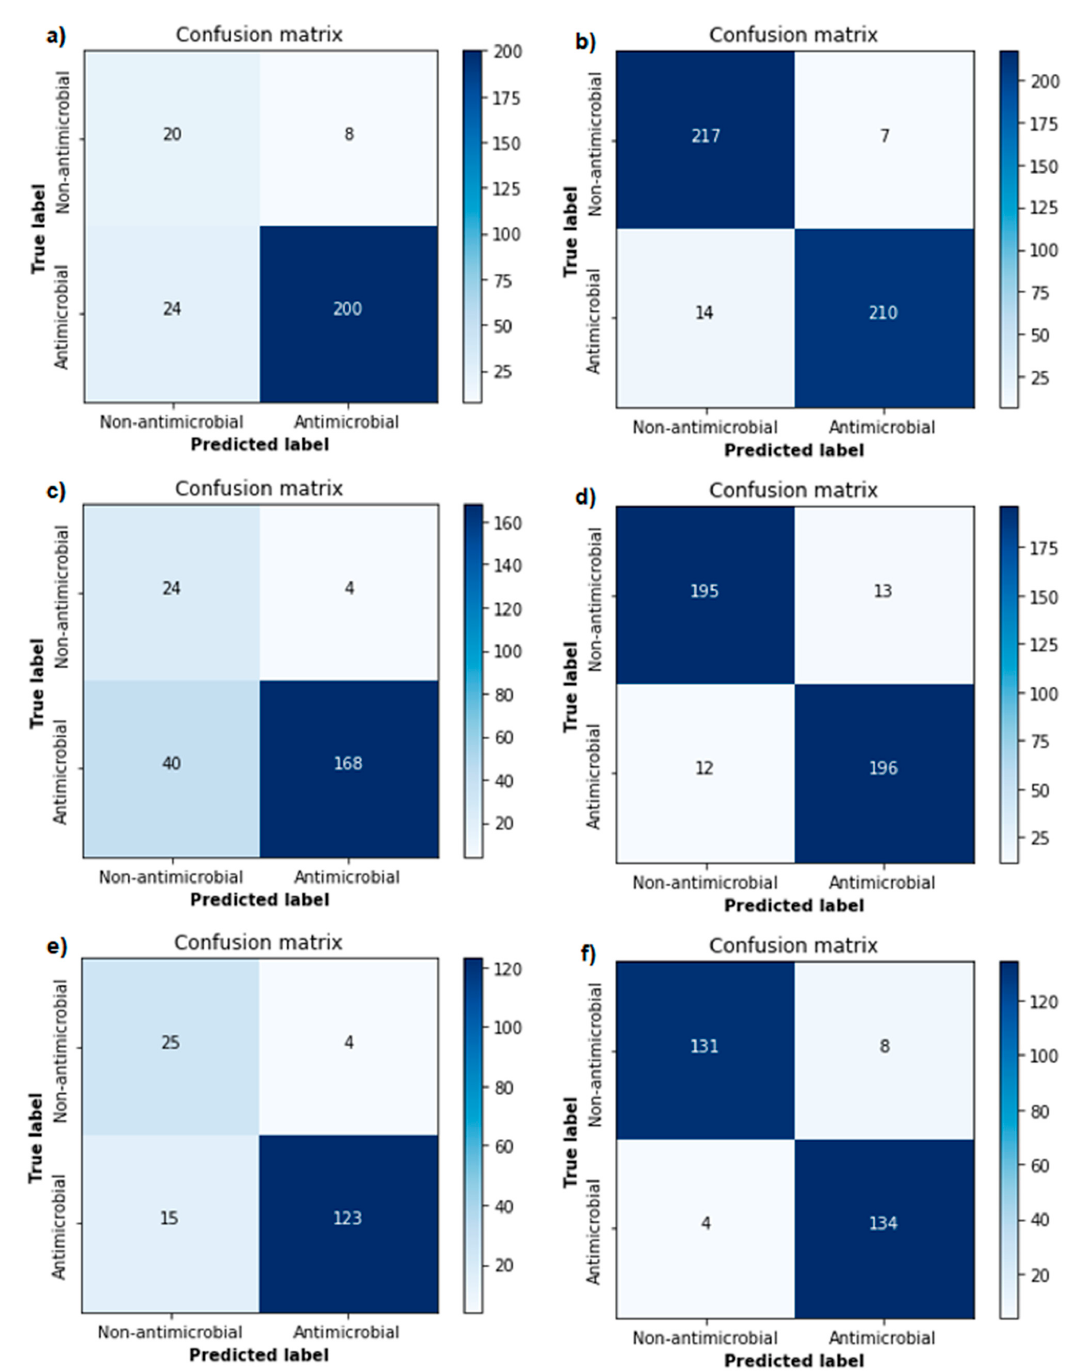
Figure 4. Confusion matrices of each version of the classification model. The left three figures ( a , c , e ) are from the models trained with negatives from antimicrobial peptide (AMP) databases (model Version 1–3), the right three ( b , d , f ) with negatives from UniProt (model Version 4–6). From top to bottom, the models were trained with a minimal inhibitory concentration (MIC) cut-off of 100 ( a , b ), 50 ( c , d ), and 10 µ M ( e , f